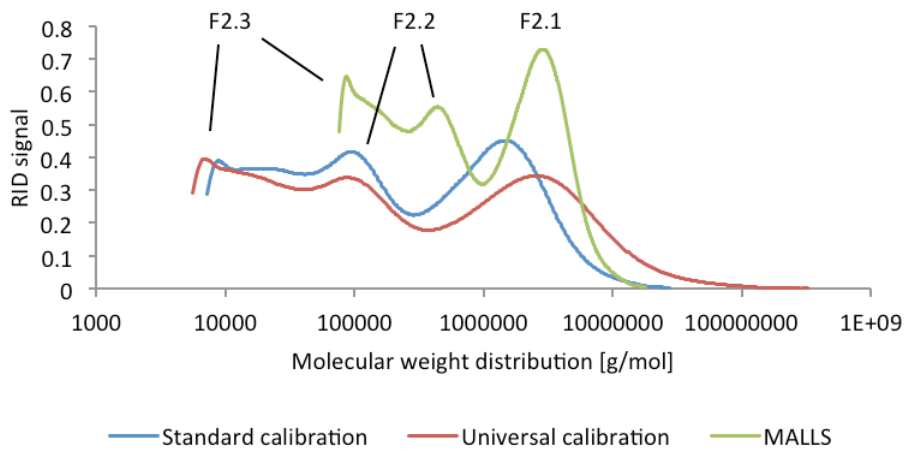
Figure 2. Molecular weight distribution of F2 determined by HP-SEC, according to standard calibration, universal calibration and multi angle light scattering (MALLS), indicating the presence of three subfractions F2.1, F2.2 and